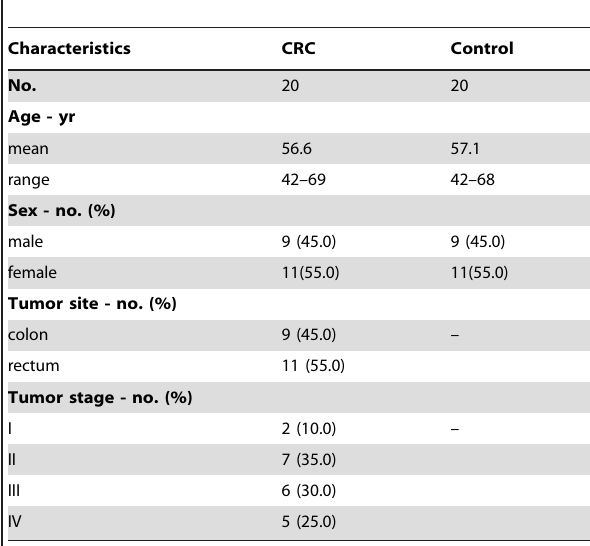
Table 1. Clinical characteristics of Controls and CRC